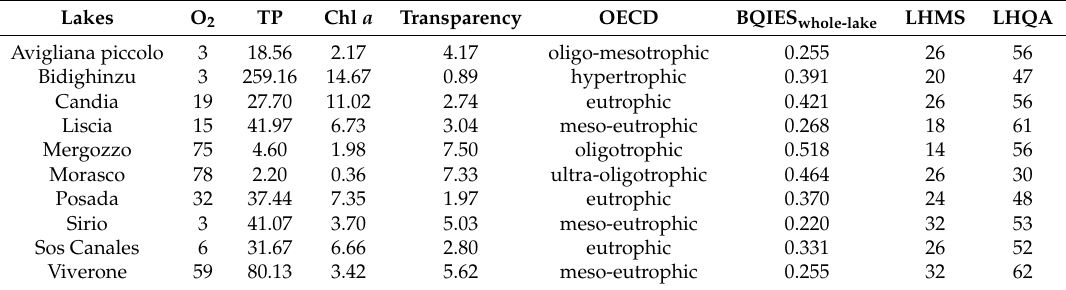
OECD classification; the other classification scores include BQIES whole-lake , LHMS and